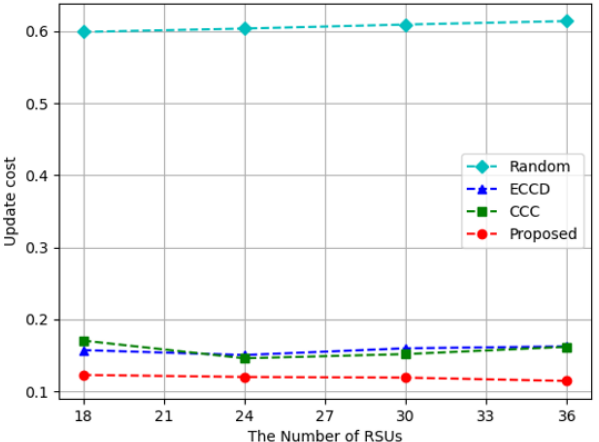
Figure 9. Update cost with respect to the increase in the number of RSUs.